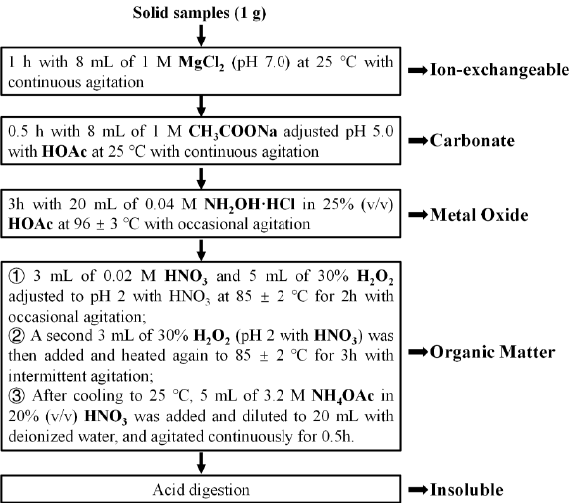
Figure 1. Sequential chemical extraction procedure used for this study.